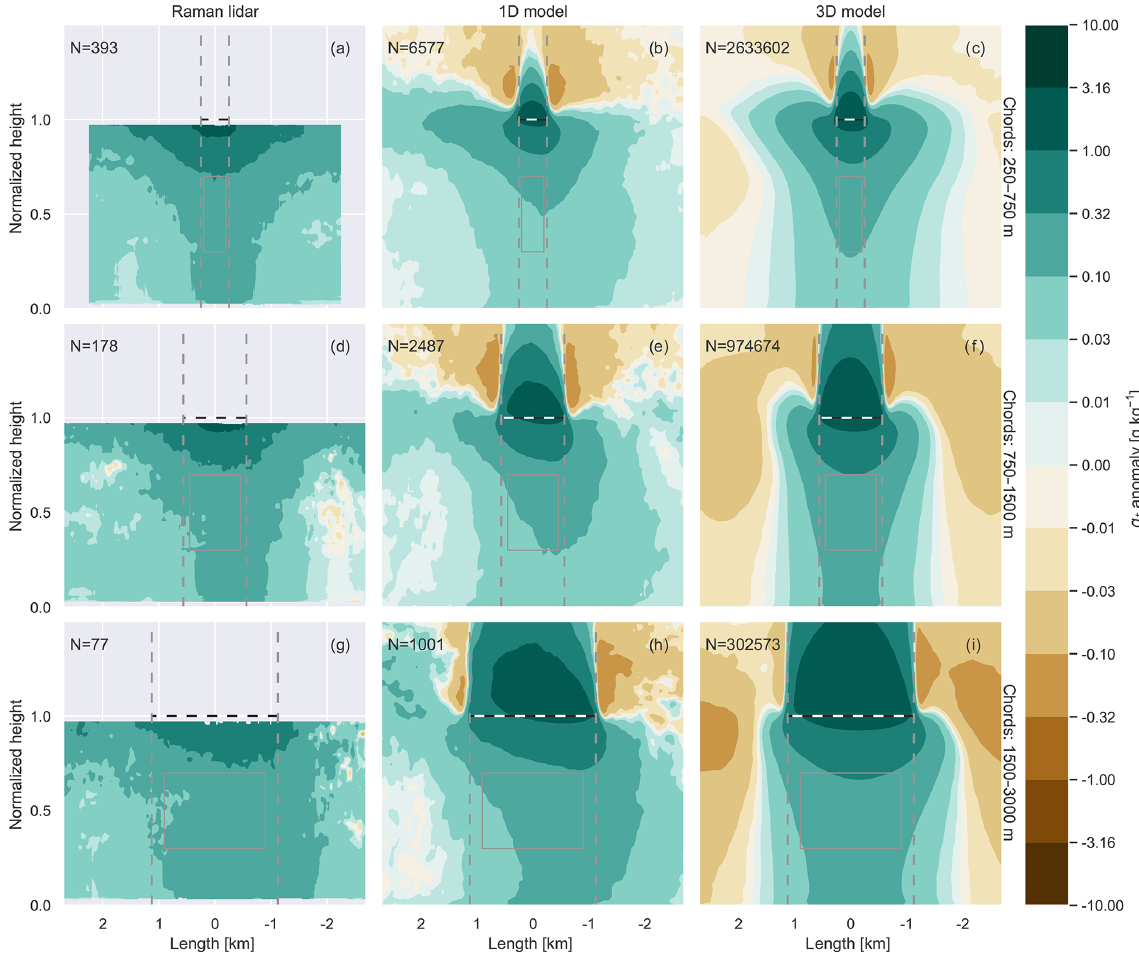
Figure 10. Scenes of q t anomalies (gkg − 1 ) from Raman lidar observations, 1D column output, and 3D column output. The scenes are composites of the normalized scenes binned by chord lengths of 250–750m (a, b, c) , 750–1500m (d, e, f) , and 1500–2500m (g, h, i) . After merging the scenes the normalized length is rescaled to match the mean length of the bin (e.g., 500m for 250–750m). The black dashed and white horizontal line marks the chord base, and the dashed grey lines mark the chord beginning and end. See Sect. 2 for information on how the scenes are computed. Note the logarithmic color bar. For reference, the water vapor values in the lower mixed layer range from 10 to 15gkg − 1